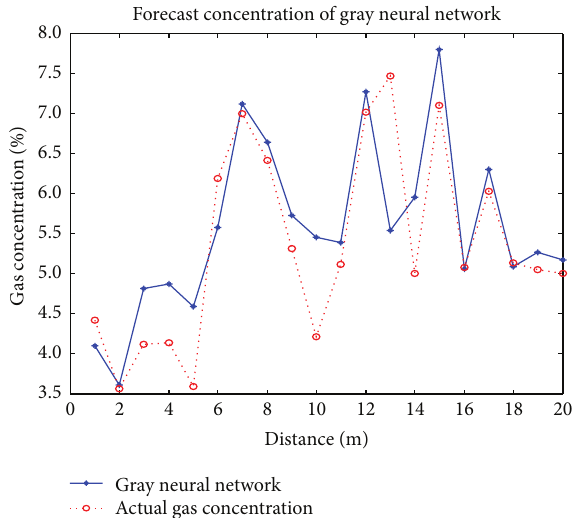
Figure 8: Comparison of the gray neural network forecast value and the actual value.